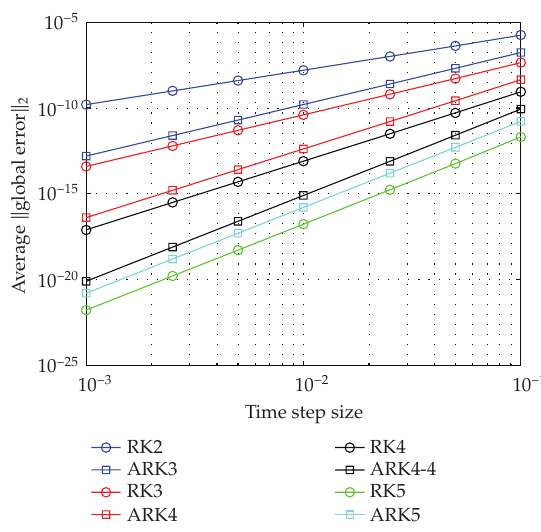
Figure 7: Accuracy plot for IVP-6 (cid:4) see caption of Figure 2 (cid:5) .